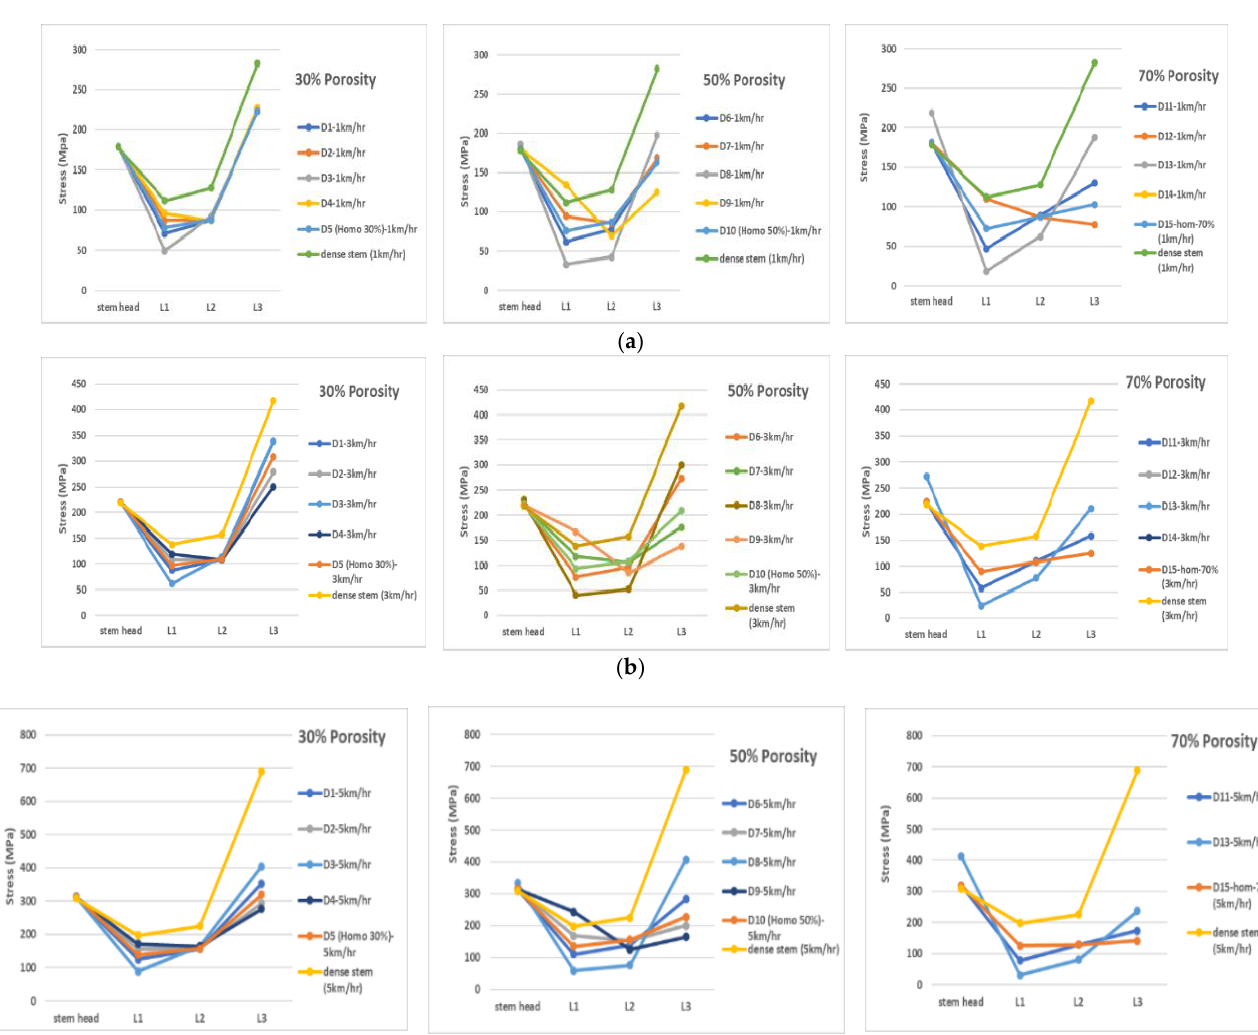
Figure 12. Von Mises stresses at the FG stems ’ layers and the bulk Ti stem: at ( a ) 1 km/hr, ( b ) 3 km/hr, and ( c ) 5 km/hr walking speeds. Micromotion at the stem – femur interface was studied for the proposed designs, this information being vital to evaluate bone tissue ingrowth, a micromotion value of more than 150 µm being considered excessive and liable to result in the instability of the implant [6,9]. The average micromotion of the proposed designs is illustrated in Figure 13. Stem designs with an average porosity of 70% showed the maximum micromotion values to be greater than 150 µm at 3 km/h and 5 km/h walking speeds besides the design with 50% porosity at 5 km/h, which is attributed to the low stiffness values of the higher porosity stems and the loading conditions associated with the walking speed. These findings agree with the previous studies [8,25]. These designs are highly susceptible to aseptic loosening, which may lead to premature failure of the stem.